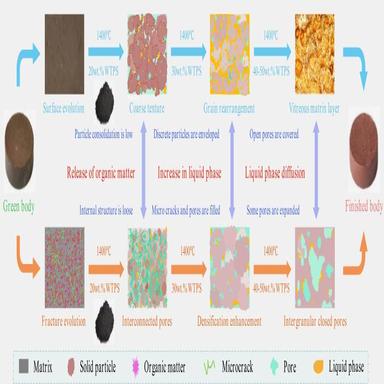
Schematic diagram on pore growth mechanism of VACs specimens sintered at 1400℃.